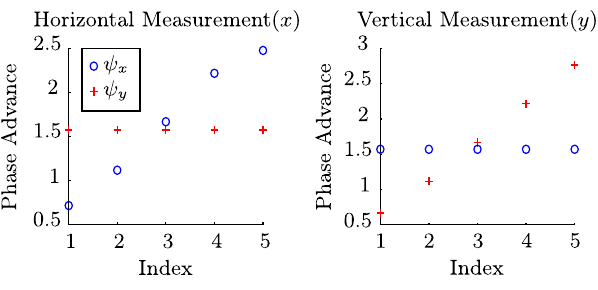
FIG. 9. Phase advances ( ψ ) for the measurements in the horizontal and the vertical